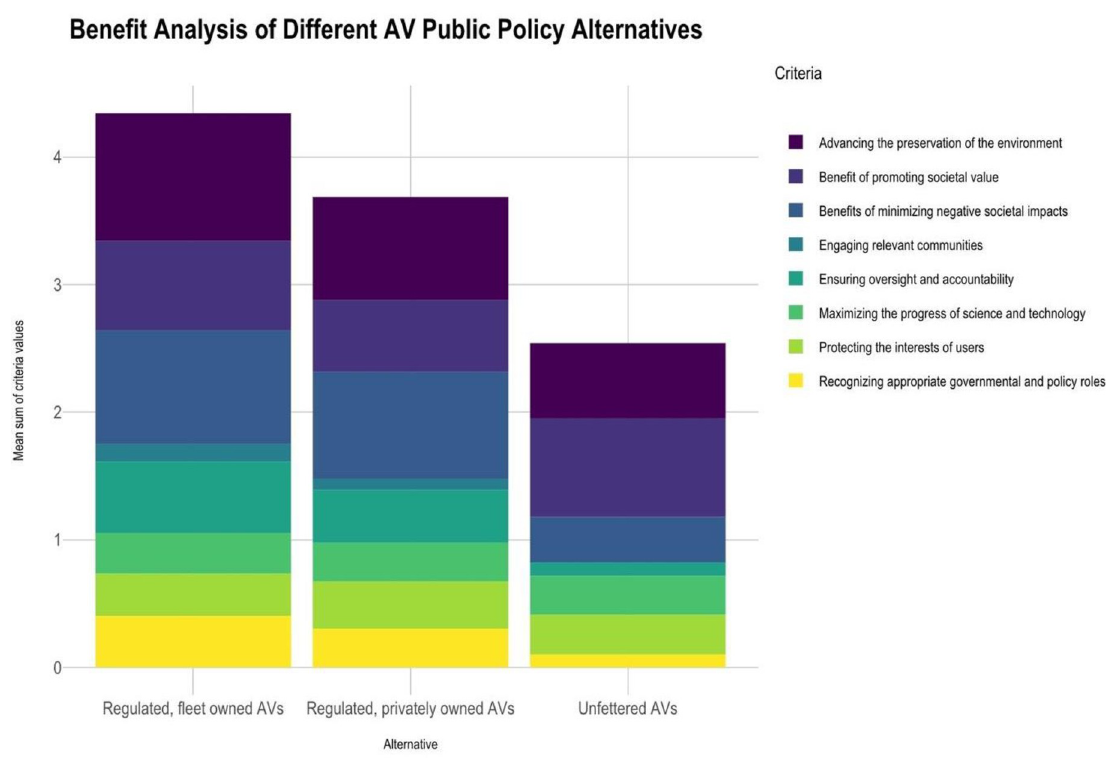
Fig 2. Benefits of different AV technology implementation, 4-point scale.